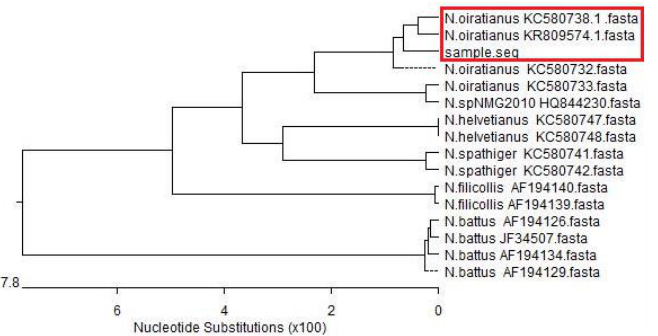
Figure 6. Phylogenetic tree of Nematodirus spp. based on ITS-rDNA sequences. The red box indicates that the isolated strain and N. oiratianus coalesced into one lineage.